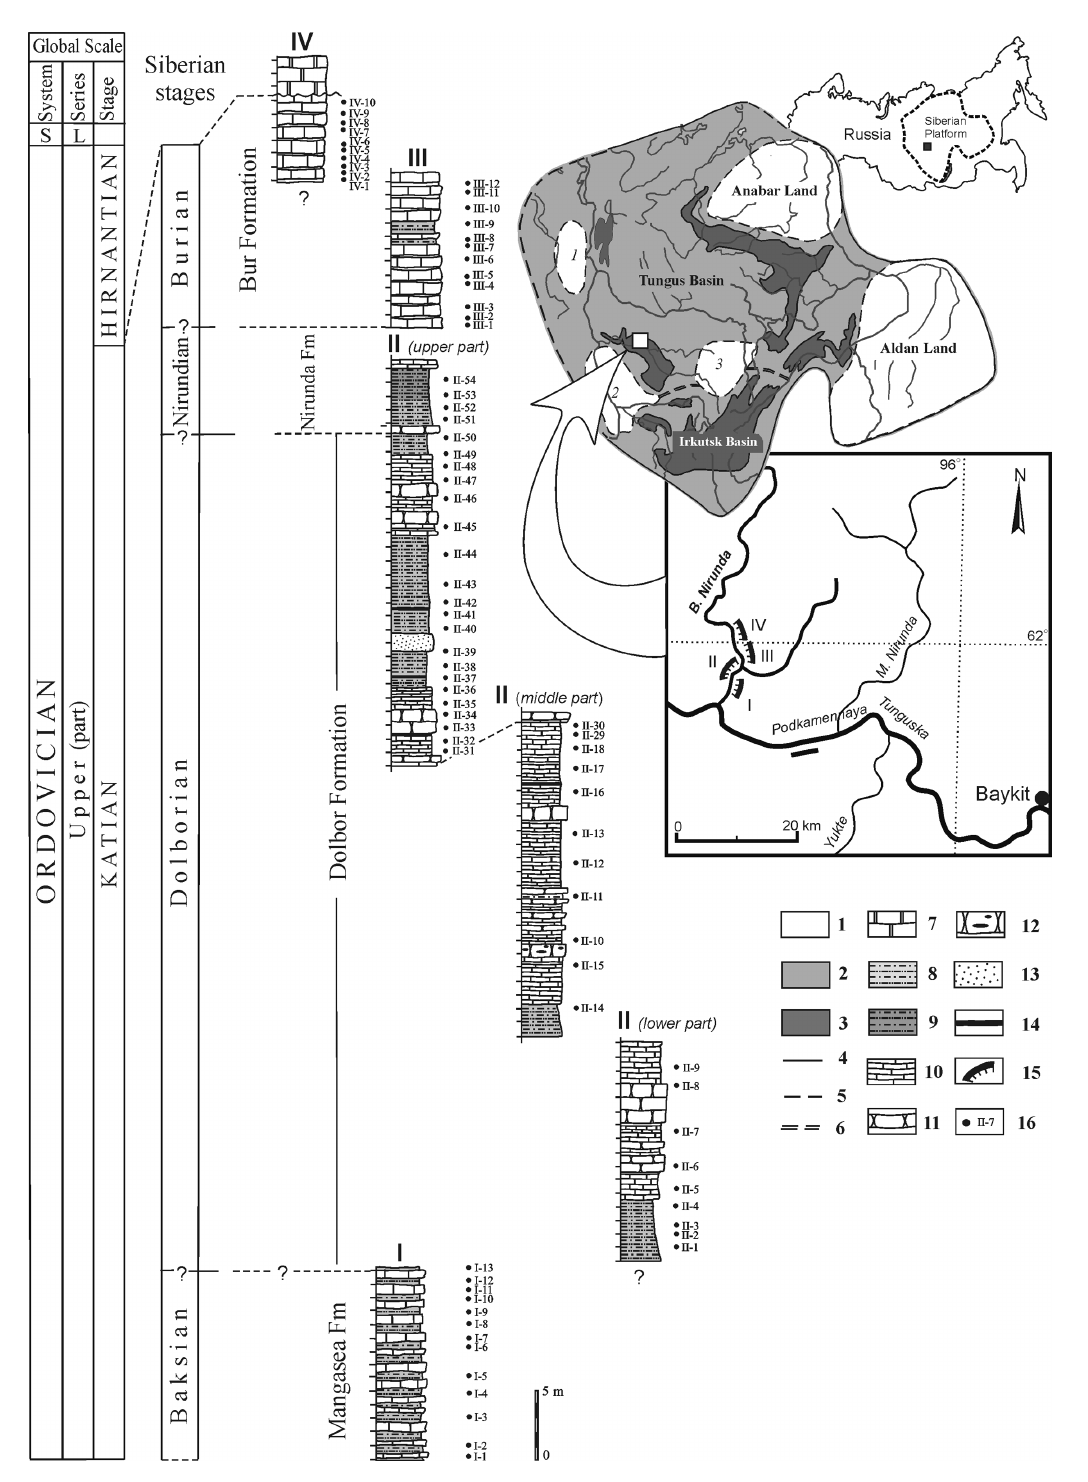
Fig. 1. Location and stratigraphy of the studied Ordovician sections. 1 , Land areas without Ordovician deposits ( 1 , Turukhan Land, 2 , Enisej Land, 3 , Katanga Land); 2 , Ordovician deposits in subsurface areas; 3 , Ordovician outcrop areas; 4 , boundary of the Siberian Platform; 5 , provisional boundaries of the Siberian Platform and land areas; 6 , provisional boundary of the Tungus and Irkutsk basins; 7 , Silurian thick-bedded dark grey limestone (mudstone to wackestone); 8 , greenish-grey siltstone; 9 , red siltstone; 10 , thin-bedded bioclastic limestone and intercalation of limestone and siltstone; 11 , thick-bedded bioclastic limestone; 12 , limestone beds with chert nodules; 13 , fine-grained quartz sandstone; 14 , K-bentonite layers; 15 , outcrops; 16 , samples collected for